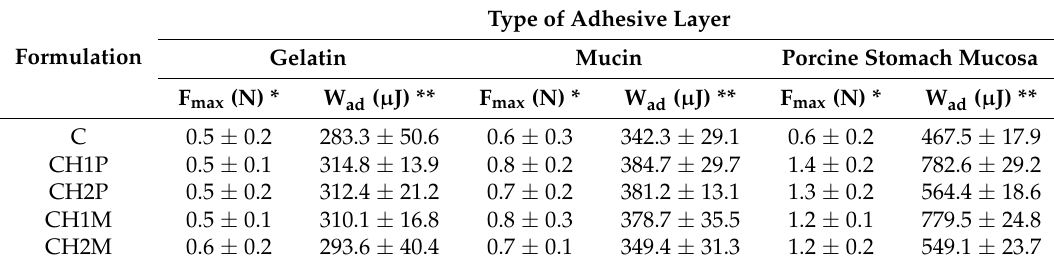
Table 2. Mucoadhesive properties of non cross-linked microparticles C and cross-linked microparticles CH1P, CH2P, CH1M, and CH2M ( n = 6).